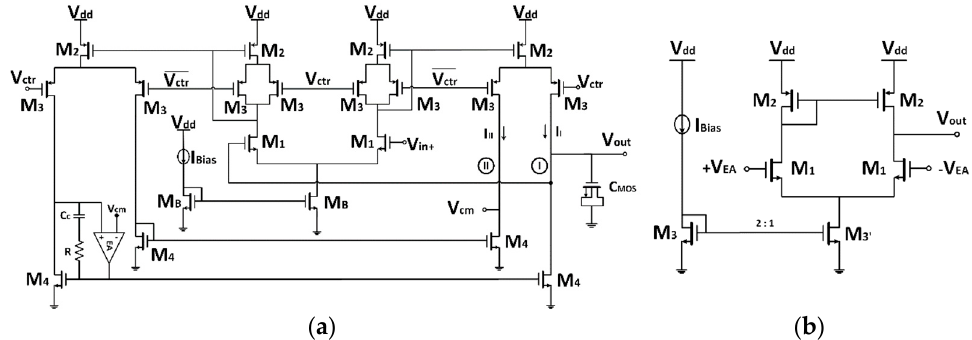
Figure 4. Schematic view of the proposed mirrored-OTA based: ( a ) LPF with Current-Steering and gain-boosting technique; and ( b ) differential pair EA used to reduce the offset.